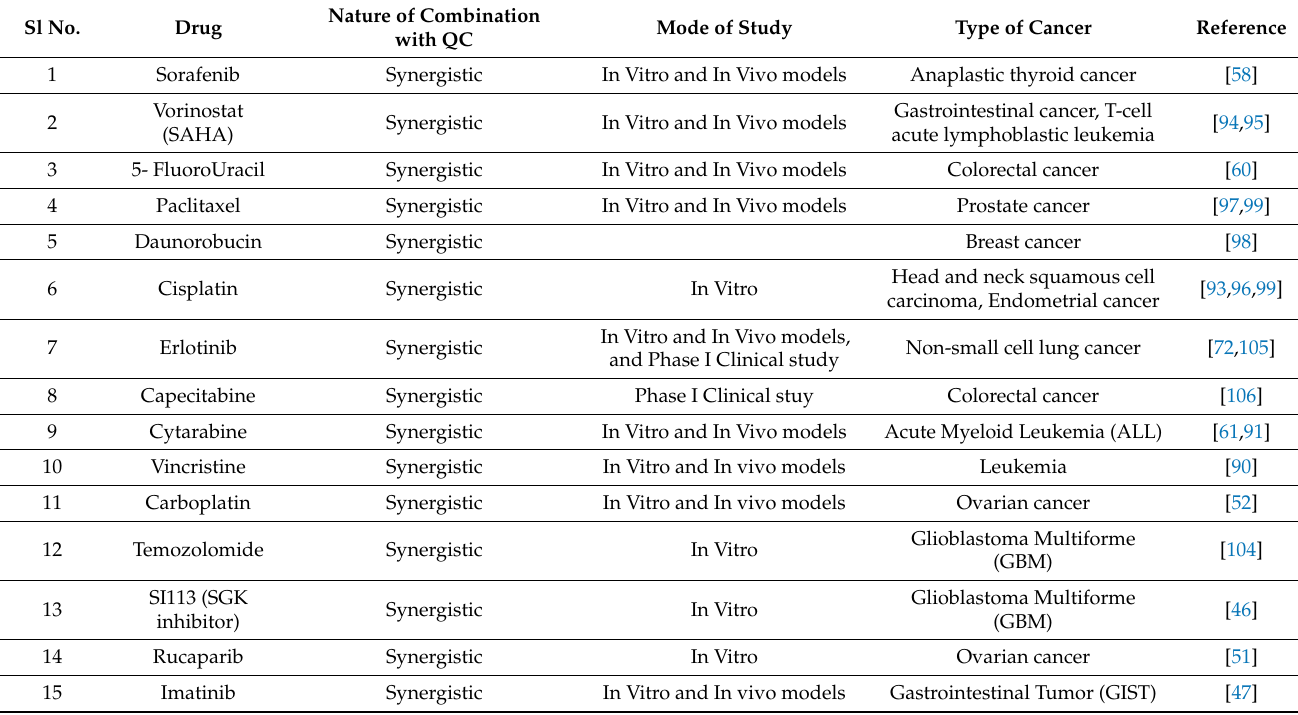
Table 3. Table describing the synergistic potential of QC with numerous clinically approved therapies. Synergy of QC with clinically approved